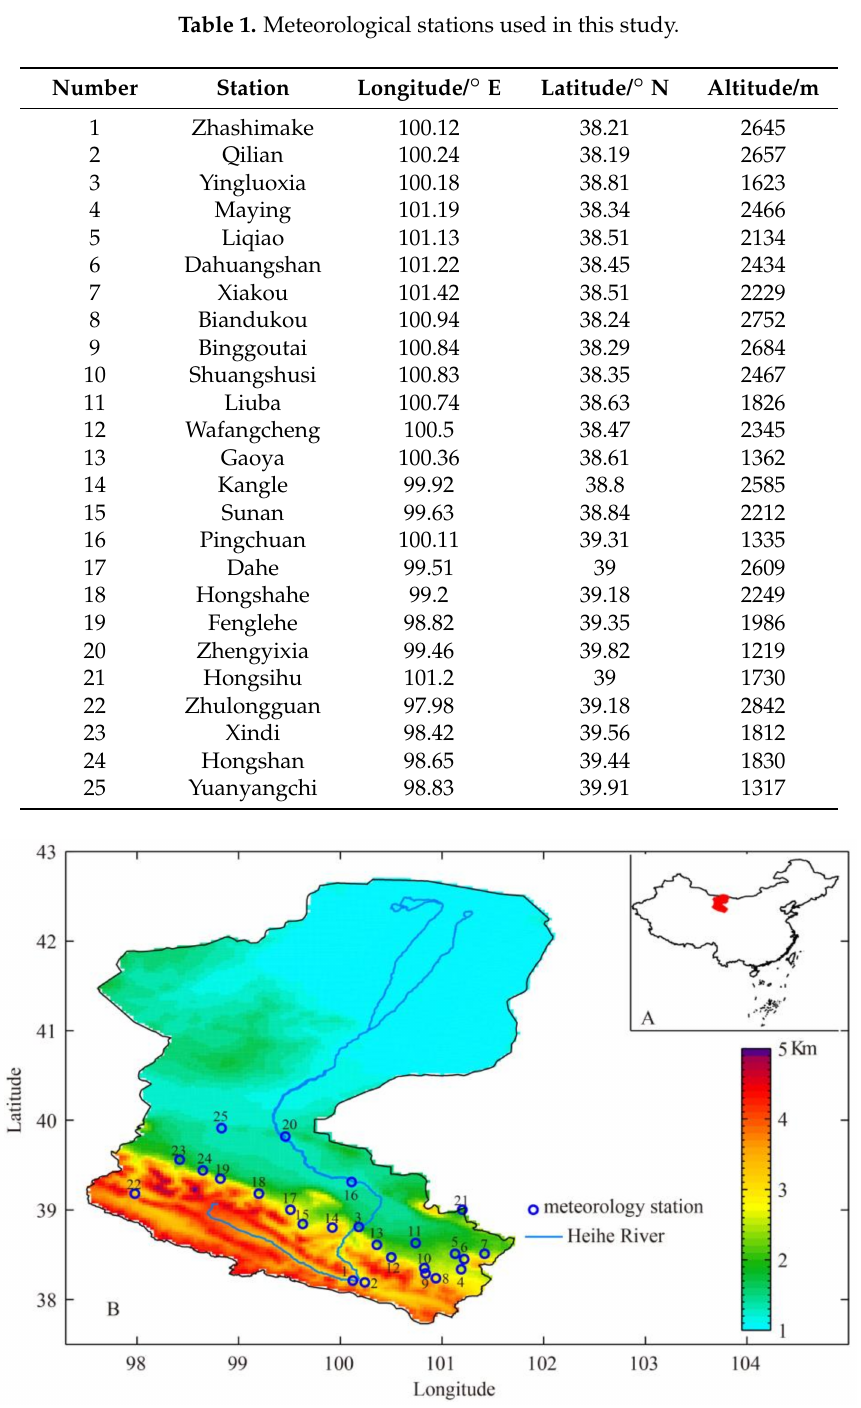
Figure 1. Location and terrains of the study area. ( A ) Location of the HRB in China; ( B ) the terrain of the HRB (the colored patches denote the elevation above sea level) and the 25 meteorological stations used in this study (see Table 1 for